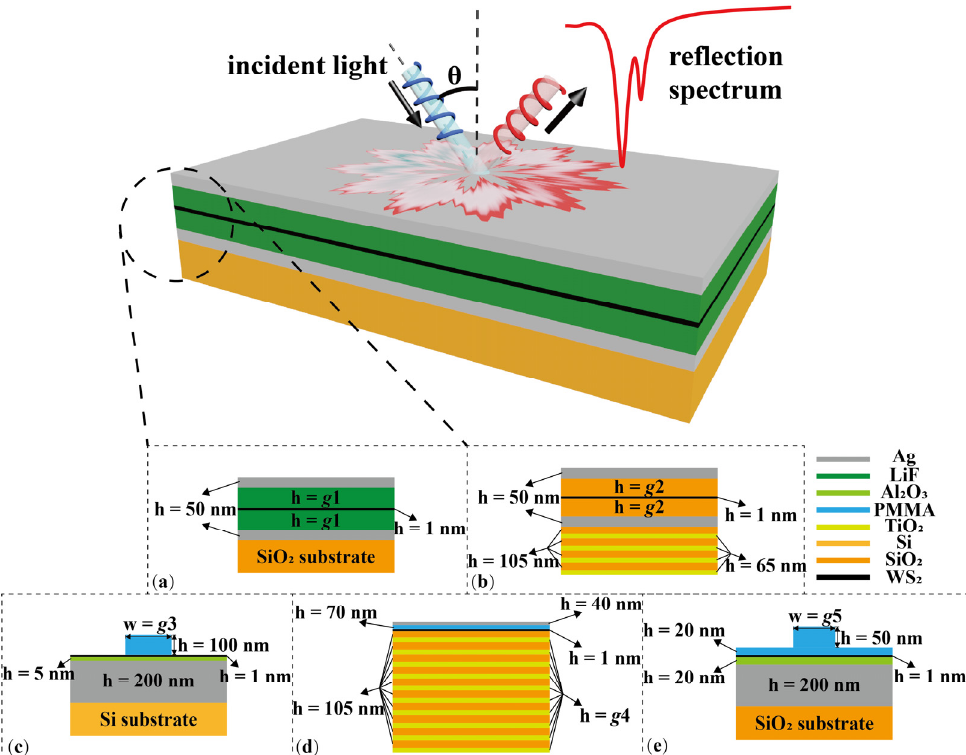
Figure 2. Schematic of different WS 2 ‐ photonic cavity ‐ integrated heterojunctions. Precisely, the top figure illustrates the light–matter interaction when the heterojunctions are irradiated by an incident light with an angle of θ , while the bottom figures represent the heterojunction structures of S1 ( a ), S2 ( b ), S3 ( c ), S4 ( d ), and S5 ( e ), respectively.